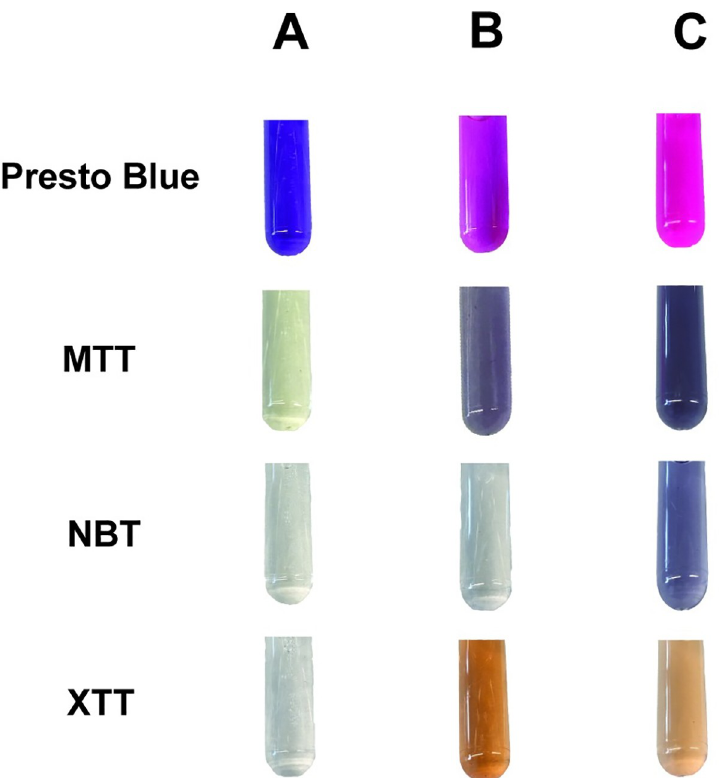
Fig 3. PrestoBlue, MTT, NBT, XTT during and after culture. N. gonorrhoeae ATCC Clinical Control Strain 49226 in 1/10 PrestoBlue, 0.1mg/mL MTT, 0.1mg/mL NBT, and 0.1mg/mL XTT: (A) At time 0, (B) At time 24hr with dye added at time 0, and (C) At time 24hr with dye added at